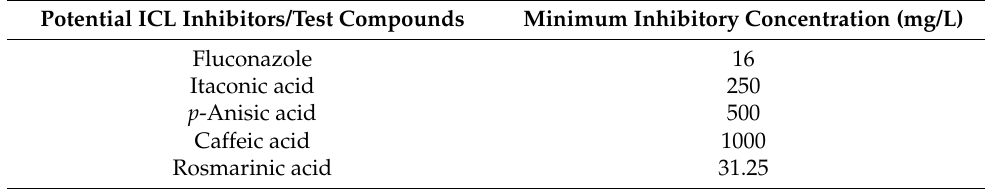
Table 1. MIC determination of potential ICL 1 inhibitor in C. albicans.